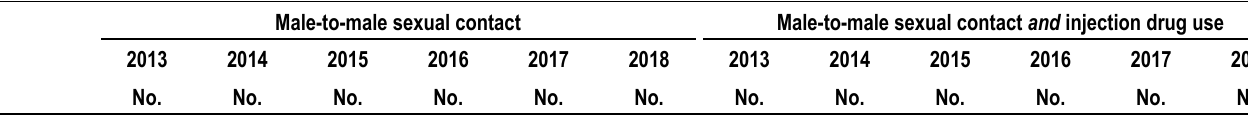
Table 7a.Diagnoses of HIV infection attributed to male-to-male sexual contact and male-to-male sexual contact and injection drug use, by selected characteristics, 2013–2018—United